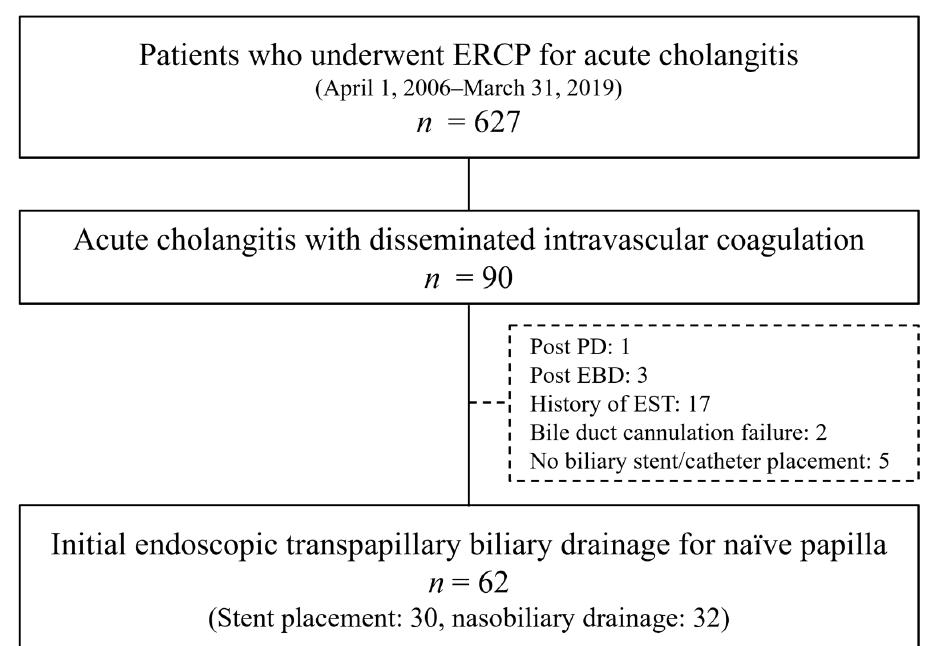
Figure 1. Flowchart of the patient-selection process. ERCP, endoscopic retrograde cholangiopancreatography; PD, pancreatoduodenectomy; EST, endoscopic sphincterotomy; EBD, endoscopic transpapillary drainage.